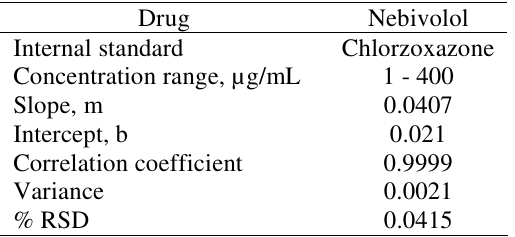
Table 1. Linear regression data for calibration curves.